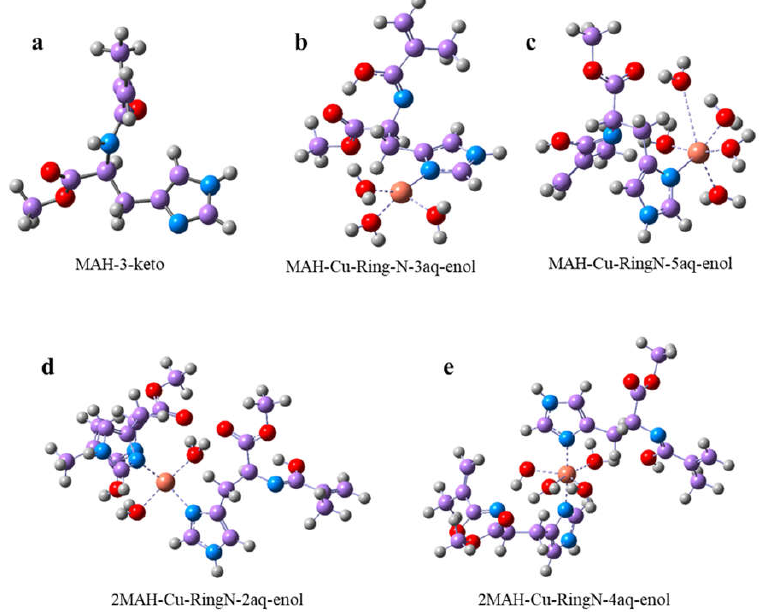
Figure 1. The stable geometries of MAH ( a ), four-fold and six-fold structures of 1:1 ( b , c ) and four-fold and six-fold structures of 2:1 ( d , e ) Cu(II)-MAH complexes, respectively. C atoms: purple; O atoms: red; H atoms: grey; N atoms: blue; and Cu(II) ions: orange. Table 1. Total and binding energies of MAH and MAH-Cu(II) complexes.